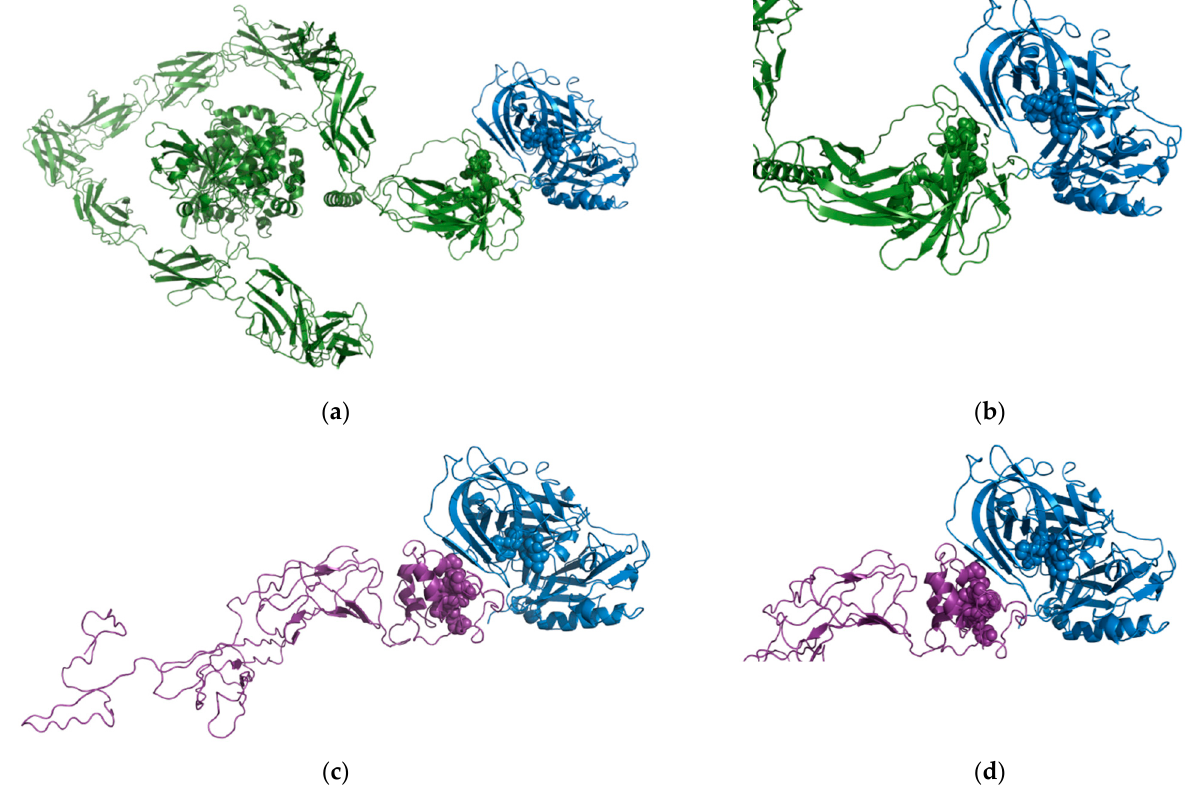
Figure 6. Predicted BACE1-PTPRD and BACE1-DCC interactions. ( a ) Overview of the predicted BACE1-PTPRD interaction. BACE1 (PDB ID 1W50) shown as blue ribbons with the active site highlighted as blue spheres and PTPRD (AlphaFold model AF-P23468-F1) shown as green ribbons with the predicted BACE1 cleavage region highlighted as green spheres. ( b ) Close-up of the predicted BACE1-PTPRD interaction. ( c ) Overview of the predicted BACE1-DCC interaction BACE1 (PDB ID 1W50) shown as blue ribbons with the active site highlighted as blue spheres and the domain of DCC predicted to be cleaved by BACE1 (modelled using I-TASSER) shown as purple ribbons with the predicted BACE1 cleavage region highlighted as purple spheres. ( d ) Close-up of the predicted BACE1-DCC interaction.